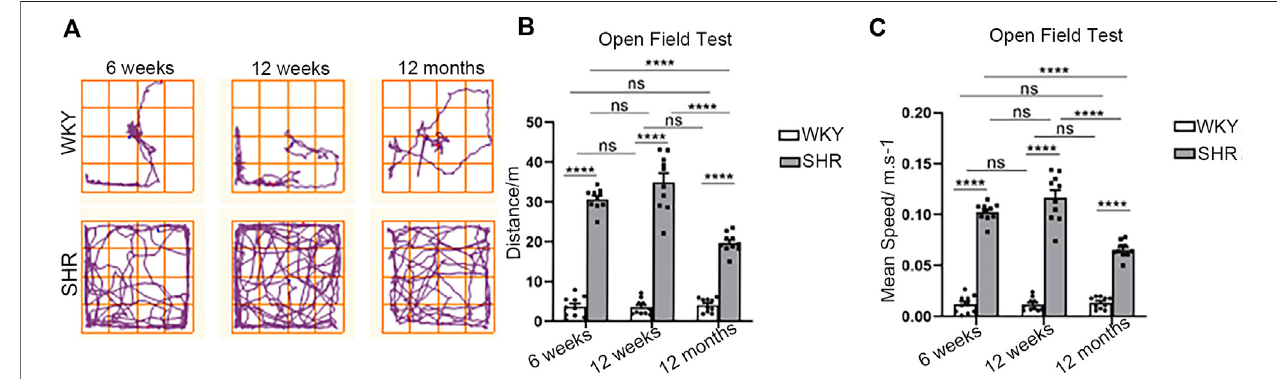
FIGURE1 | Open fi eld test in WKY and SHR rats. (A) The typical trajectory ofthe WKY and SHR ratsin OFT. (B) Total distance traveled in the OFT. **** p < 0.0001; ns = not signi fi cant. n = 10. (C) Mean speed in the OFT. **** p < 0.0001; ns = not signi fi cant. n = 10. The values represent mean ± SEM.